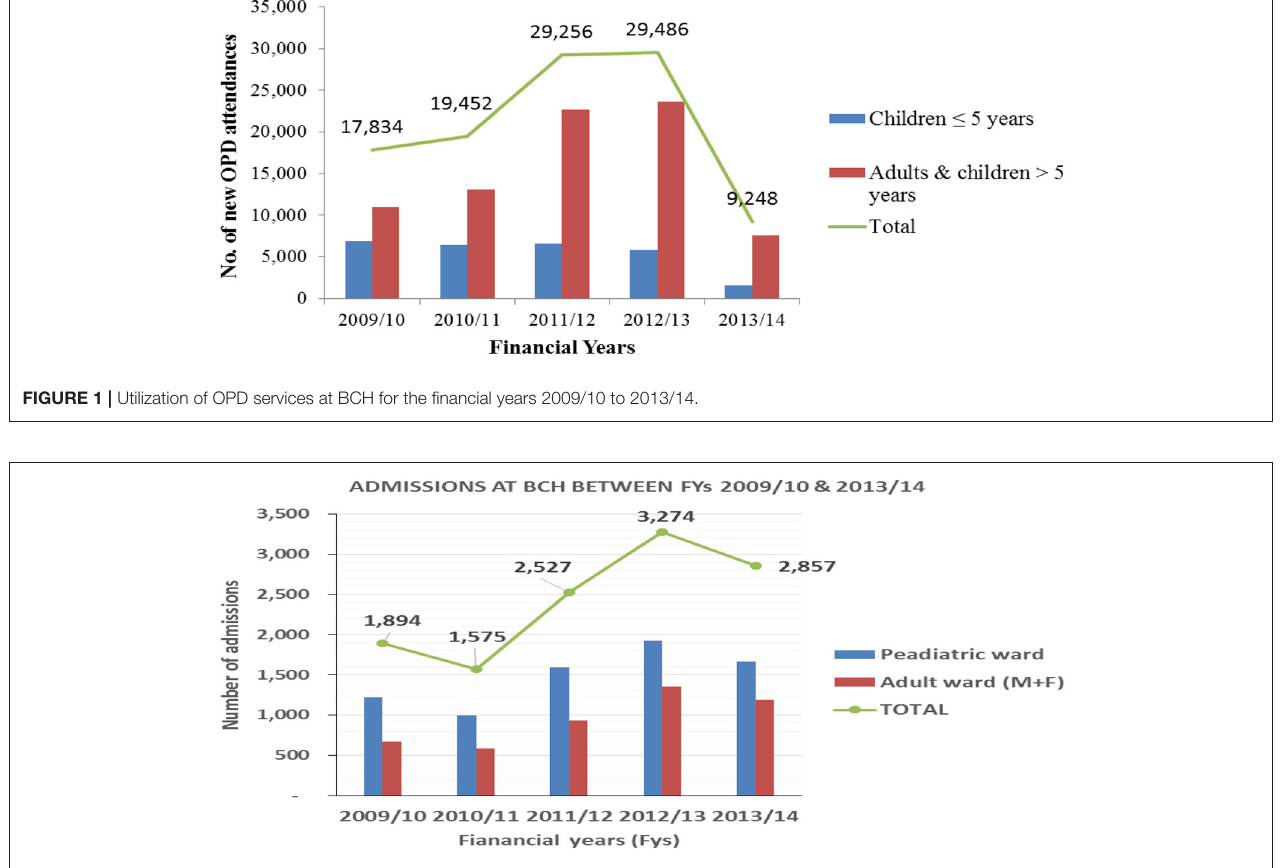
FIGURE 2 | Admissions at BCH for the financial years 2009/10 to